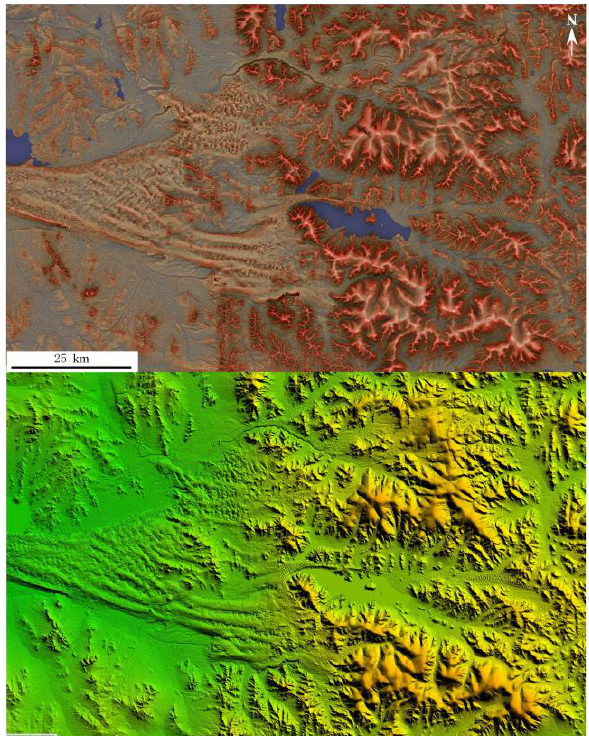
Figure 6. Desert distribution in western Mongolia. RRIM (upper) and color shaded map (lower)